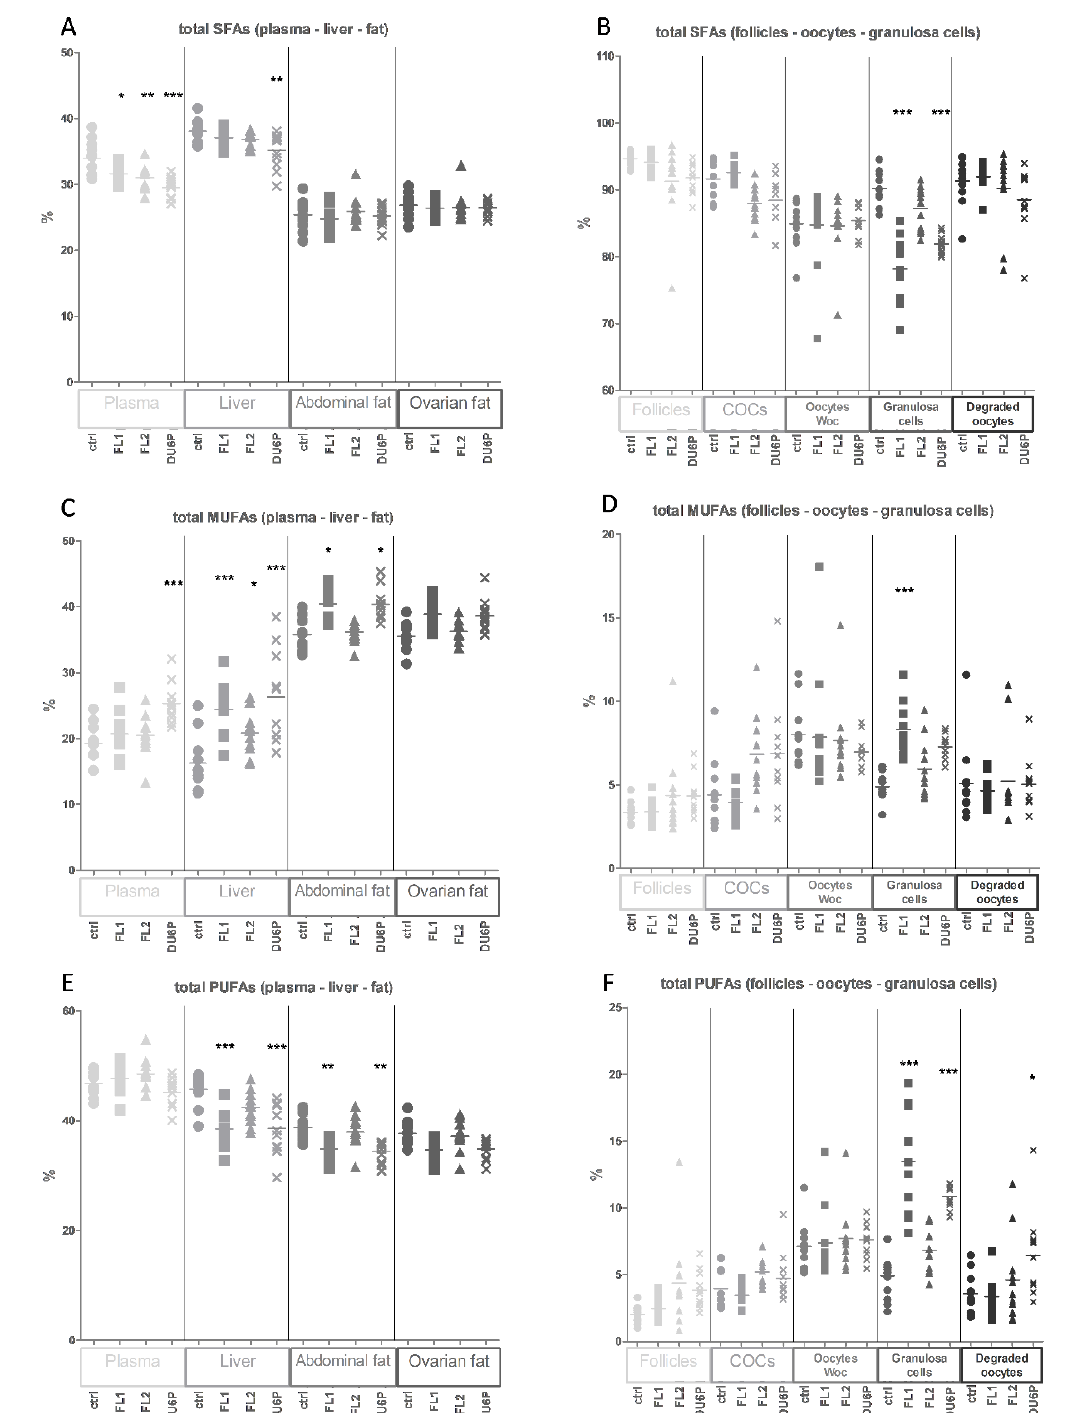
Figure 5. Fatty acid composition in control (circles), FL1 (squares), FL2 (triangles) and DU6P (crosses). ( A , C , F ) (large symbols) show the composition of SFAs ( A ), MUFAs ( C ) and PUFAs ( E ) in plasma, liver, abdominal and ovarian fat. ( B – D ) (small symbols) show the composition of SFAs ( B ), MUFAs ( D ) and PUFAs ( F ) in follicles, COCs (Cumulus–oocyte complex), oocytes WoC (without cumulus), granulosa cells and degraded oocytes. Different tissues are represented using different tonalities. Data are illustrated as the mean ± SEM (standard error of the mean) and designated significant if p < 0.05 (Bonferroni posttest: * p < 0.05; ** p < 0.01; *** p < 0.005, in comparison with control of the same group).